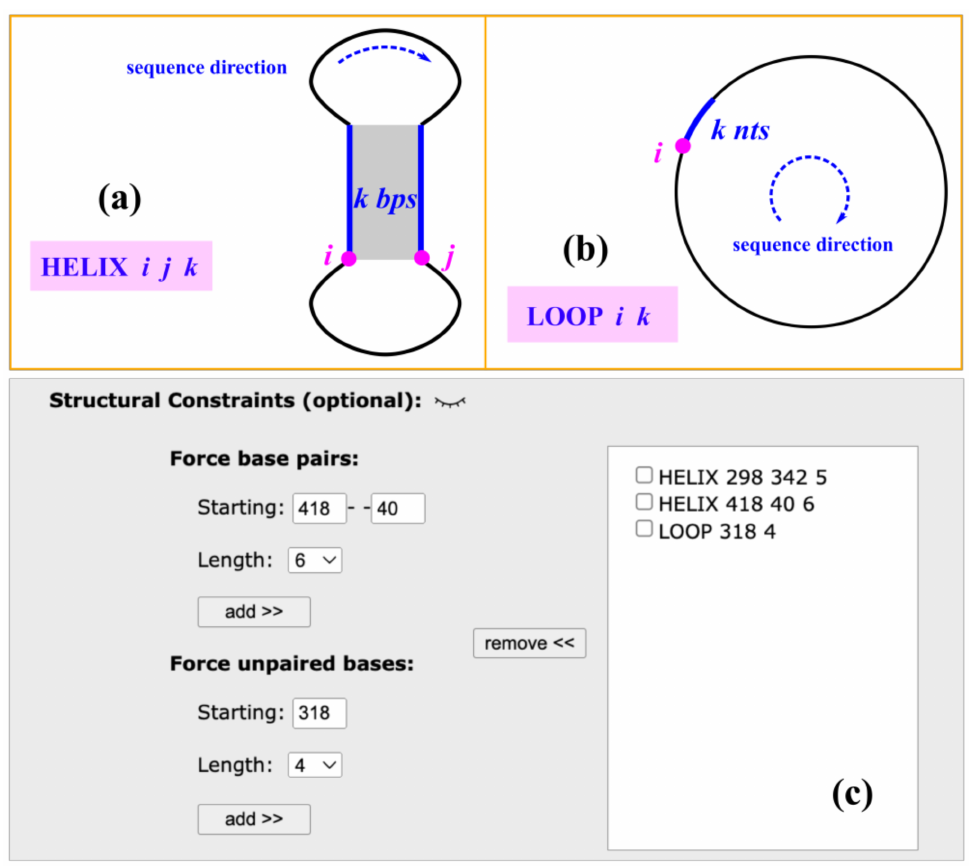
Figure 2. Structural constraints of forcing base pairs (HELIX i j k ) in ( a ) and forcing unpaired bases (LOOP i k ) in ( b ). ( c ) Example of setting the structural constraints for cRNAsp12 prediction. Here, i and j are the nucleotide numbering within the range of (1, N ), with N as the length of the circRNA sequence, and k as the number of base pairs or unpaired